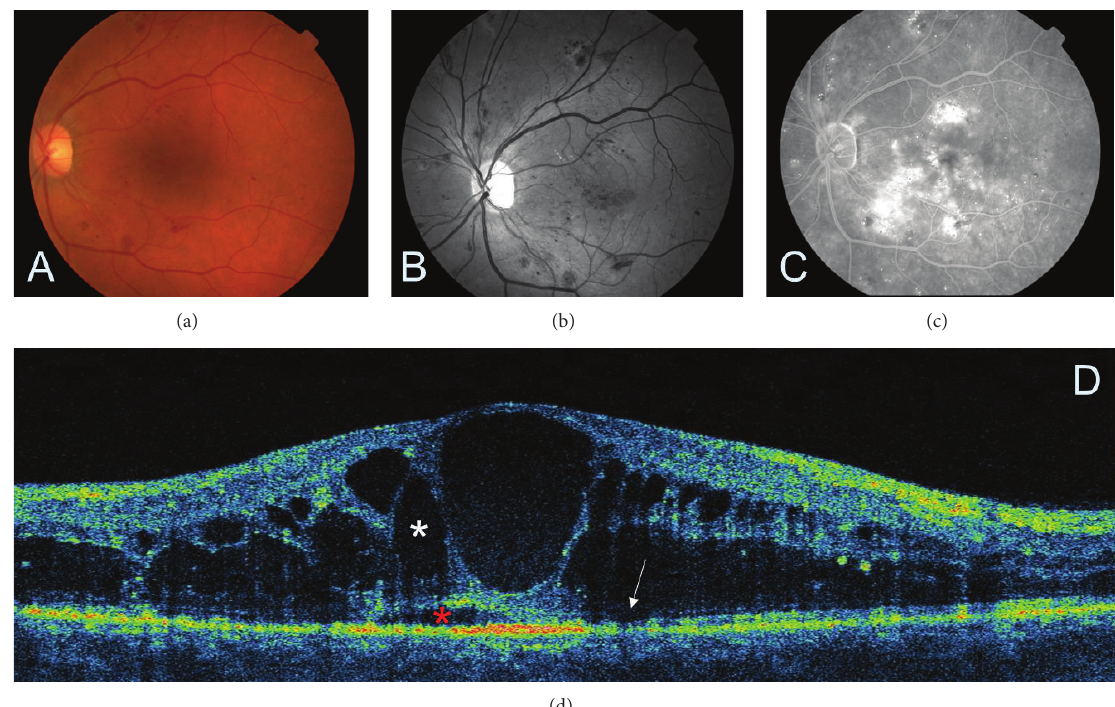
Figure 4: Cystoid DME. (a) Colour fundus photography showing a few intraretinal haemorrhages. (b) The corresponding red-free image of the fundus. (c) Late-stage fluorescein angiogram depicting a cystoid pattern of foveal hyperfluorescence with surrounding diffuse leakage. (d) SDOCT demonstrating hyporeflective cystic spaces within the retina (white asterisk) and subretinal fluid accumulation (red asterisk) consistent with macular oedema. The abnormal reflectivity of photoreceptor layer is indicated by a white arrow.